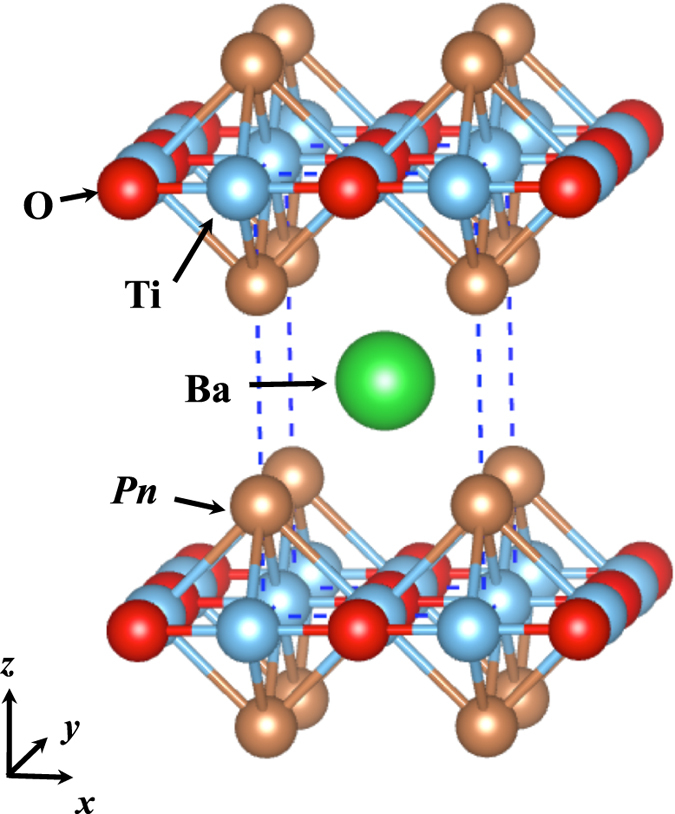
Undistorted crystal structures of BaTi2Pn2O (Pn = As, Sb, and Bi).The crystal symmetry is P4/mmm (No. 123).